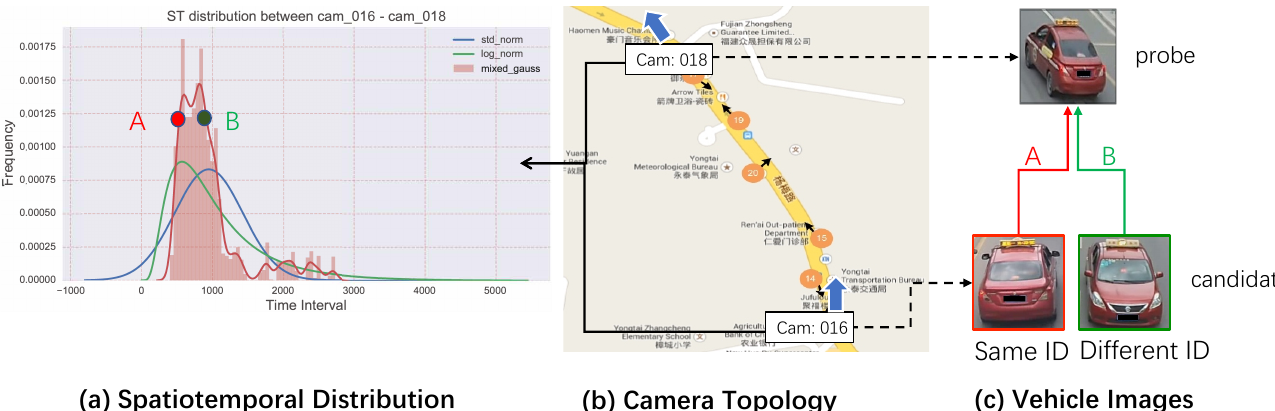
Figure 2. ( a ) Illustration of the spatio-temporal distribution between cam_018 and cam_016. ( b ) The camera topology. The blue arrow indicates the camera shooting direction. ( c ) The probe image captured by cam_018 and the candidates images captured by cam_016. Branch A is an ID-matched pair, and the time interval between the probe and candidate corresponds to point A on the curve. Branch B is ID a non-matched pair, and the time interval between the probe and candidate corresponds to point B on the curve. Correct results cannot be obtained only by vehicle visual features and spatio- temporal information. It can be observed that a combination of camera shooting direction and vehicles’ poses can be used to assist the